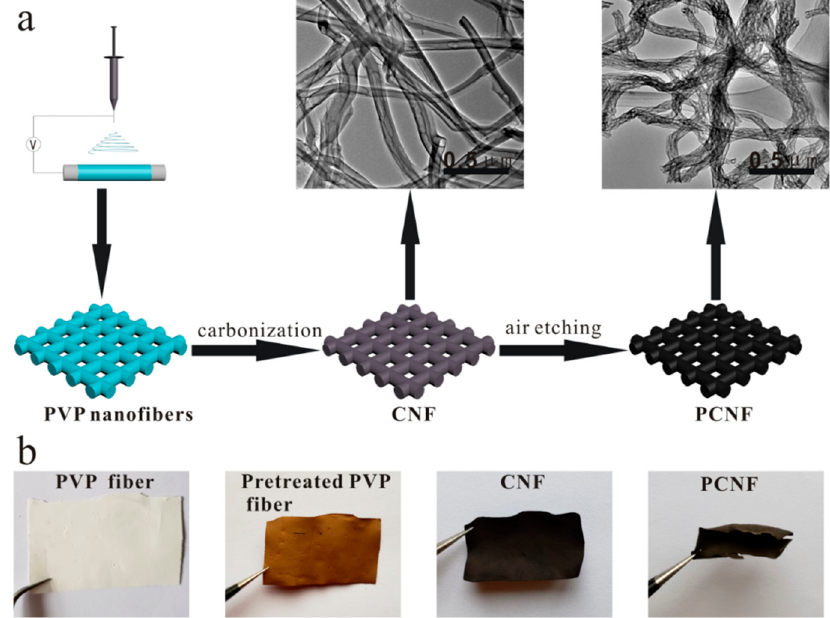
Figure 1. ( a ) Diagrammatization of synthesis process of the polyporous carbon nanofibers films; ( b ) Photographic images of the PVP fiber, pretreated PVP fiber, CNF and PCNF.